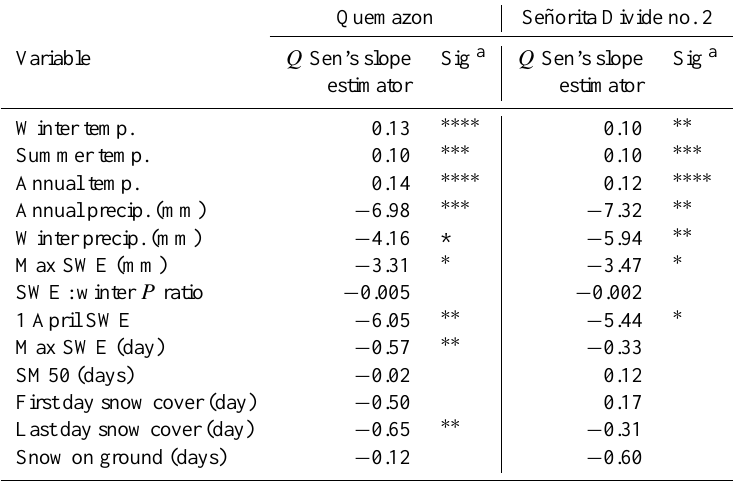
Table 3. Climatic time series trends for the Quemazon and Señorita Divide no. 2 SNOTEL stations from 1984–2012. A trend in the precip- itation time series was evaluated with the MKT and Sen’s slope estimator. Trends were considered statistically significant at p ≤ 0 . 1. The results showed an increasing trend in winter, summer, and annual temperature in the two stations. Annual and winter precipitation, maximum SWE, and 1 April SWE decreased in both stations during the 29 years analyzed. The last day of snow cover decreases significantly only at the Quemazon station. No significant trend was observed for the SWE:winter P ratio, duration of snowmelt SM50, and length of snow on the ground.